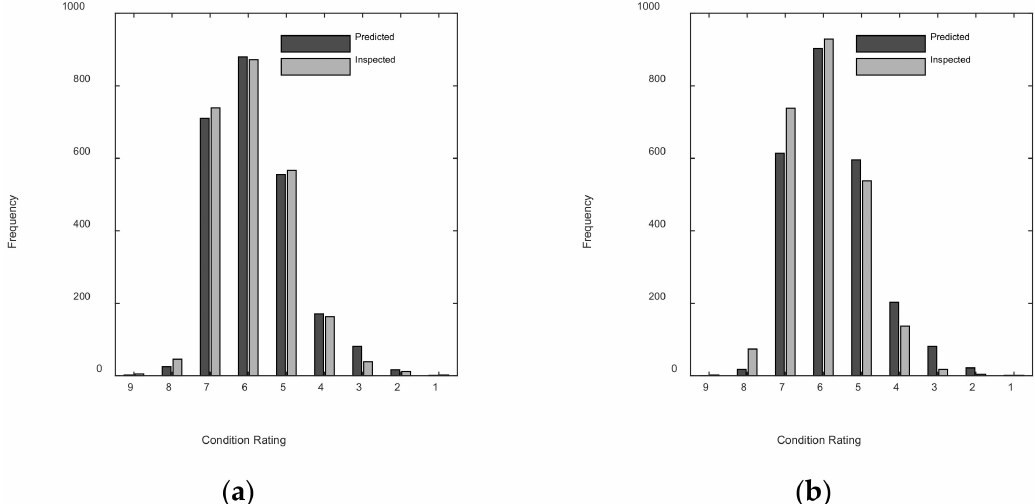
Figure 15. Bridge distribution comparison between inspection and predicted condition ratings using second level of classification tree for ( a ) two-year and ( b ) four-year